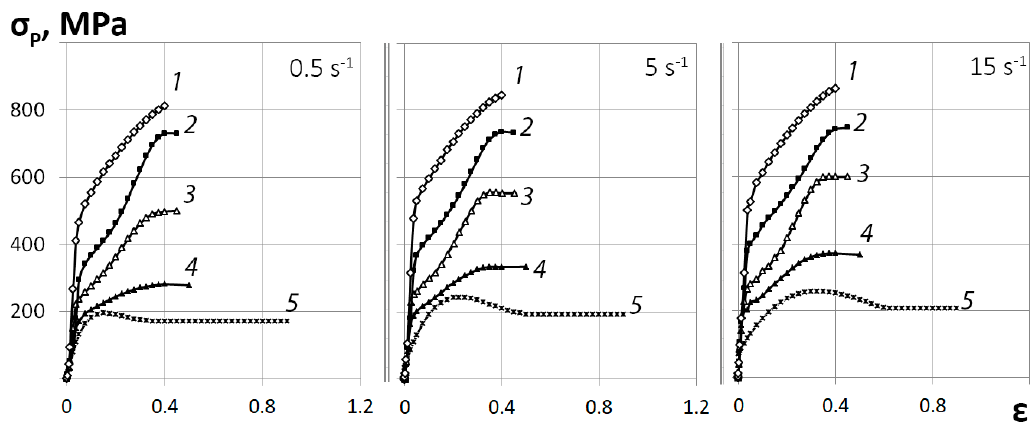
Figure 4. Flow curves of Zr-1%Nb alloy obtained using the “Gleeble 3800” plastometer by compression method in the range of strain rates 0.5–15 s − 1 at temperatures: 1–20 °C; 2–200 °C; 3–350 °C; 4–500 °C; 5–650 °C.